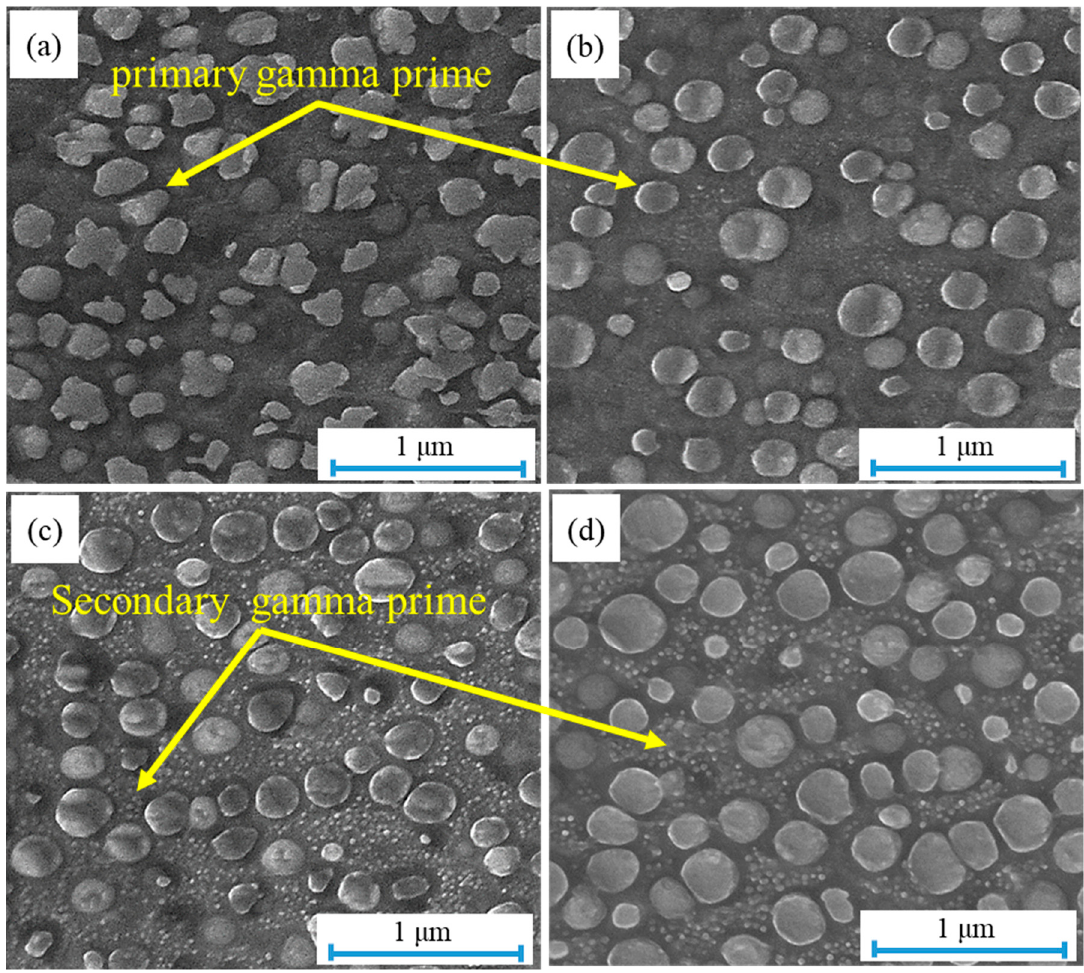
Figure 7. E ff ect of di ff erent pre-welding heat treatments on the microstructure of BM; ( a ) specimen A, Figure 7. Effect of different pre-welding heat treatments on the microstructure of BM; ( a ) specimen ( b ) specimen B, ( c ) specimen C and ( d ) specimen A, ( b ) specimen B, ( c ) specimen C and ( d ) specimen D.